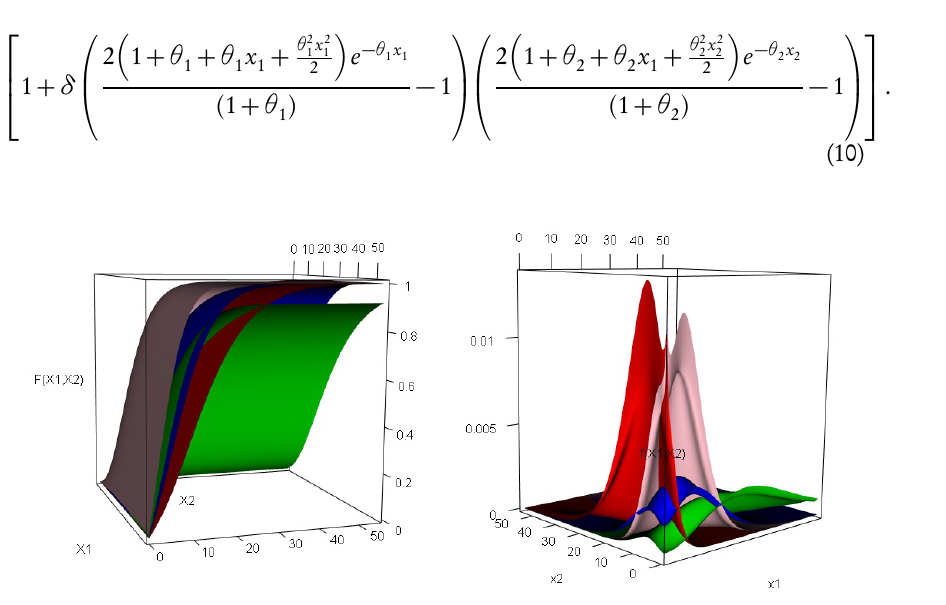
Figure 2 – CDF BXG distribution. Figure 3 – PDF BXG distribution.